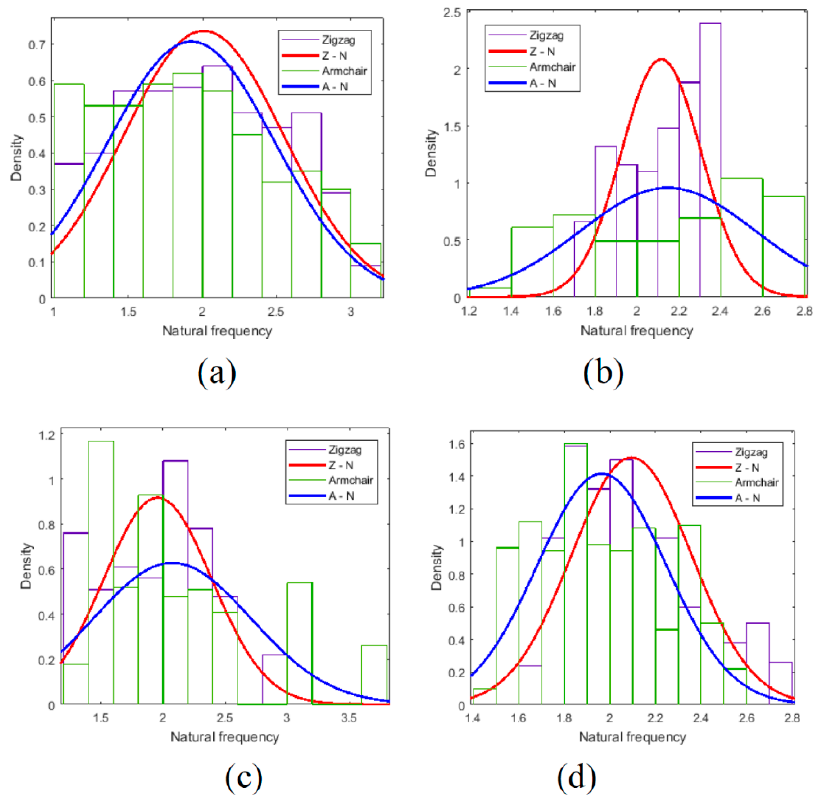
Figure 9. Probability density distribution of natural frequency for uncertainty analysis ( a ) is for Bz and Ba , ( b ) is for Dz and Da , ( c ) is for Wz and Wa , ( d ) is for Hz and Ha , and the unit for the natural frequency is THz.